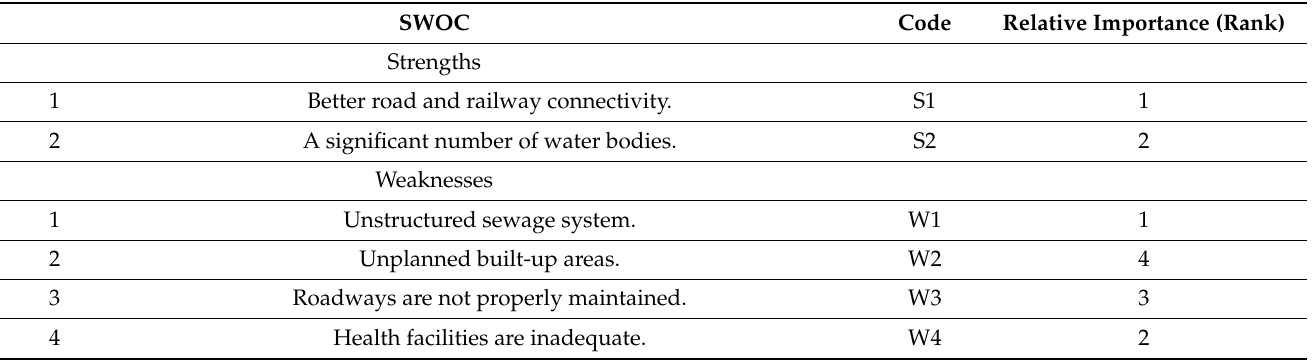
Table 16. Selected strengths, weaknesses, opportunities, and challenges (SWOC) in Nabadwip Municipality